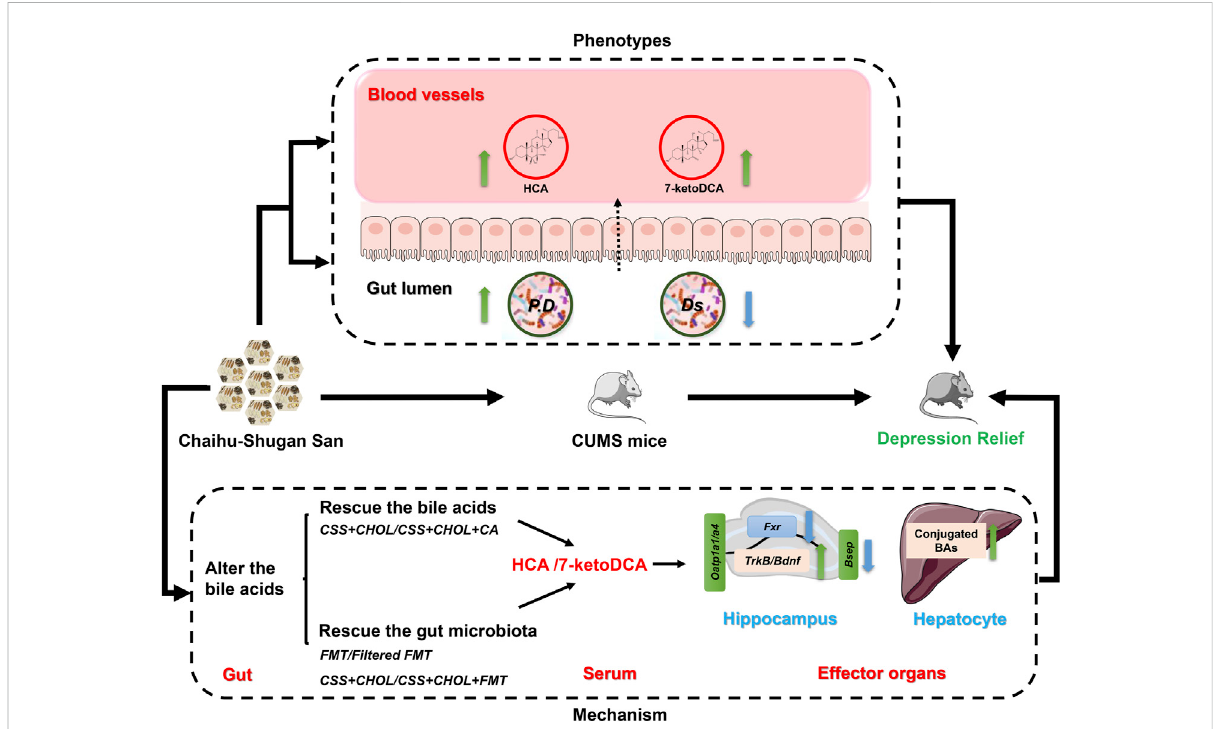
FIGURE 8 Overview of potential mechanism of CSS antidepressant action. We propose that CSS mitigates depression in CUMS mice by altering the constitution of gut micro fl ora, thereby increasing serum levels of speci fi c BAs and metabolites such as HCA and 7-ketoDCA. These BAs regulate critical cell signaling cascades in the hippocampus such as neurotrophins, which are implicated in the pathogenesis of depression. P. D: Parabacteriods distasonis ; Ds: